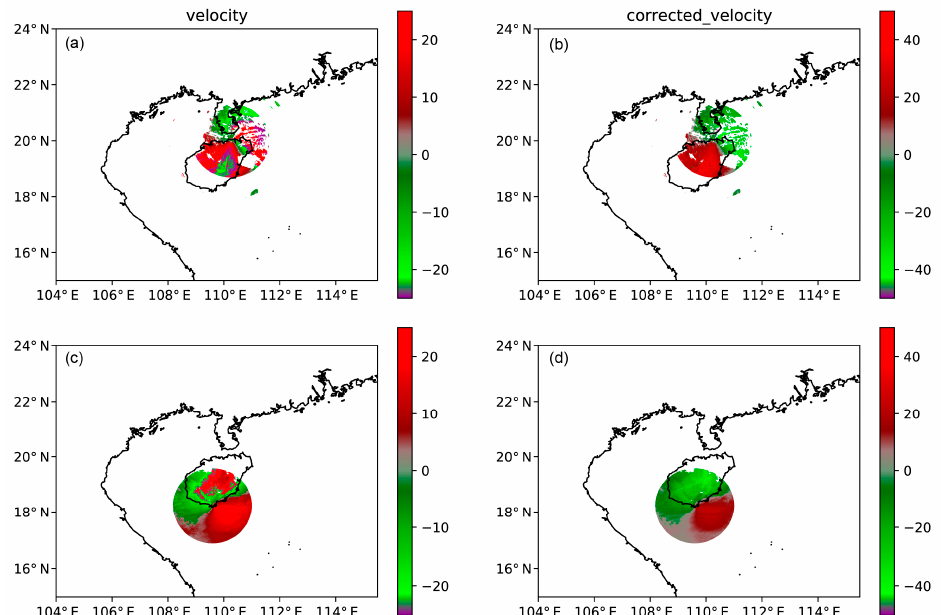
Figure 3. Doppler radar radial velocity of the first sweep at 0600UTC 13 October. ( a ) Raw data of HKRD; ( b ) unfolding data of HKRD; ( c ) raw data of SYRD; ( d ) unfolding data of